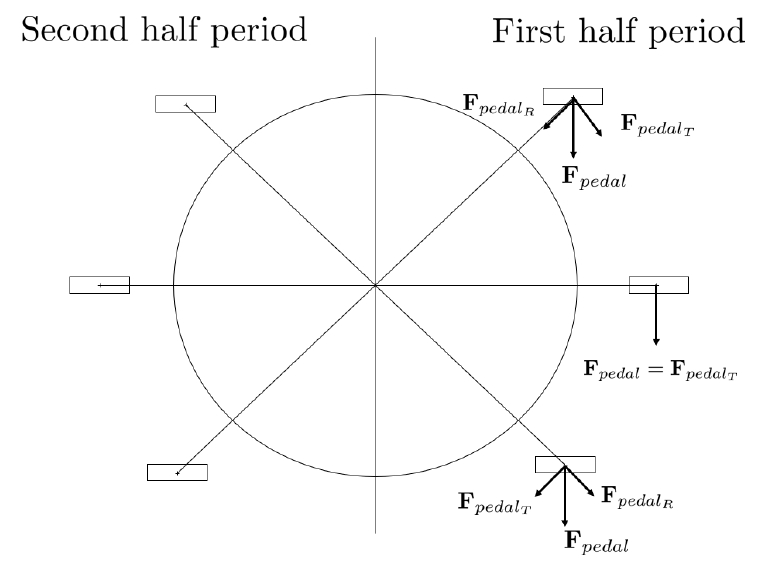
Figure 4. Example of pedalling torque obtained when applying a pedalling force with a constant module and application